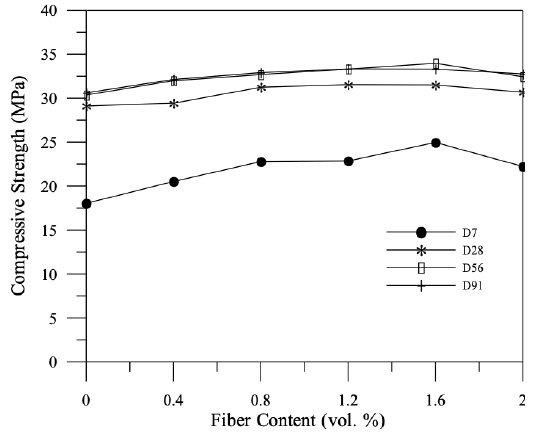
Figure 2. Compressive strength development curves of polyolefin fiber concrete with